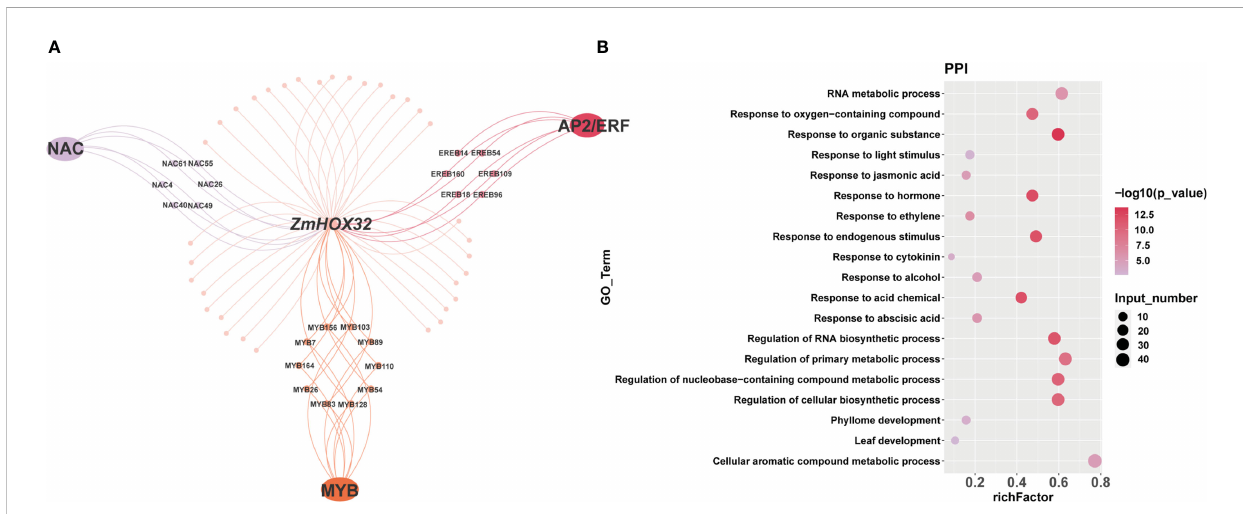
FIGURE 4 Enrichment of intercalating proteins of ZmHOX32. (A) Regulatory network of the intercalating proteins of ZmHOX32. (B) Degree of enrichment of intercalating proteins of